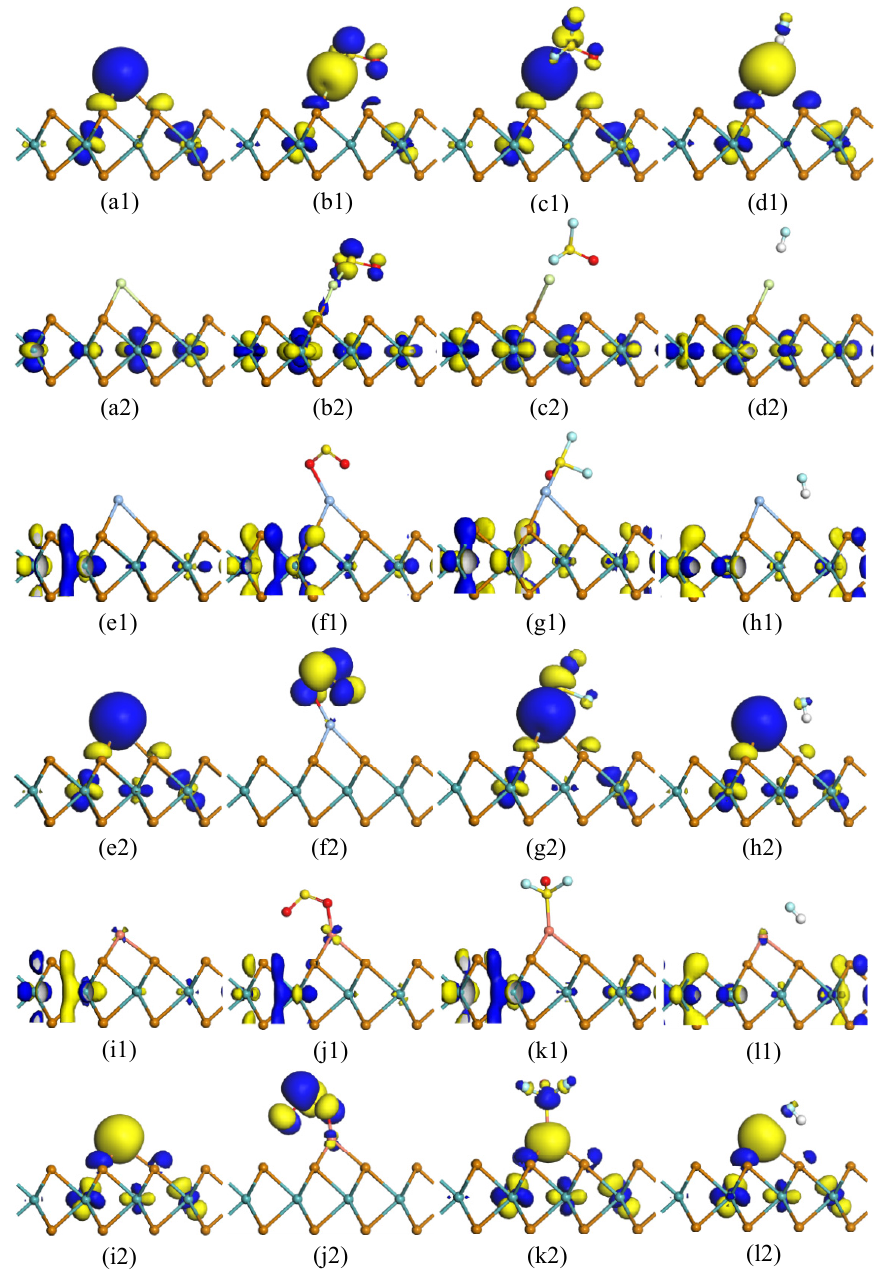
Figure 7. HOMO and LUMO distribution of TM-MoTe 2 monolayer before and after gas adsorption. ( a1 ) Au-MoTe 2 -HOMO, ( a2 ) Au-MoTe 2 -LUMO, ( b1 ) Au-MoTe 2 /SO 2 -HOMO, ( b2 ) Au-MoTe 2 /SO 2 -LUMO, ( c1 ) Au-MoTe 2 /SOF 2 -HOMO, ( c2 ) Au-MoTe 2 /SOF 2 -LUMO, ( d1 ) Au-MoTe 2 /HF-HOMO, ( d2 ) Au-MoTe 2 /HF-LUMO, ( e1 ) Ag-MoTe 2 -HOMO, ( e2 ) Ag-MoTe 2 -LUMO, ( f1 ) Ag-MoTe 2 /SO 2 -HOMO, ( f2 ) Ag-MoTe 2 /SO 2 -LUMO, ( g1 ) Ag-MoTe 2 /SOF 2 -HOMO, ( g2 ) Ag-MoTe 2 /SOF 2 -LUMO, ( h1 ) Ag-MoTe 2 /HF-HOMO, ( h2 ) Ag-MoTe 2 /HF-LUMO, ( i1 ) Cu-MoTe 2 -HOMO, ( i2 ) Cu-MoTe 2 -LUMO, ( j1 ) Cu-MoTe 2 /SO 2 -HOMO, ( j2 ) Cu-MoTe 2 /SO 2 -LUMO, ( k1 ) Cu-MoTe 2 /SOF 2 -HOMO, ( k2 ) Cu-MoTe 2 /SOF 2 -LUMO, ( l1 ) Cu-MoTe 2 /HF-HOMO, ( l2 ) Cu-MoTe 2 /HF-LUMO.